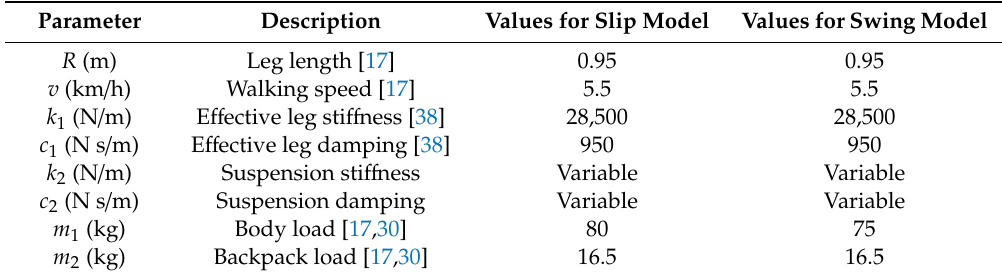
Table 1. Parameters for the spring-mass-damper model.